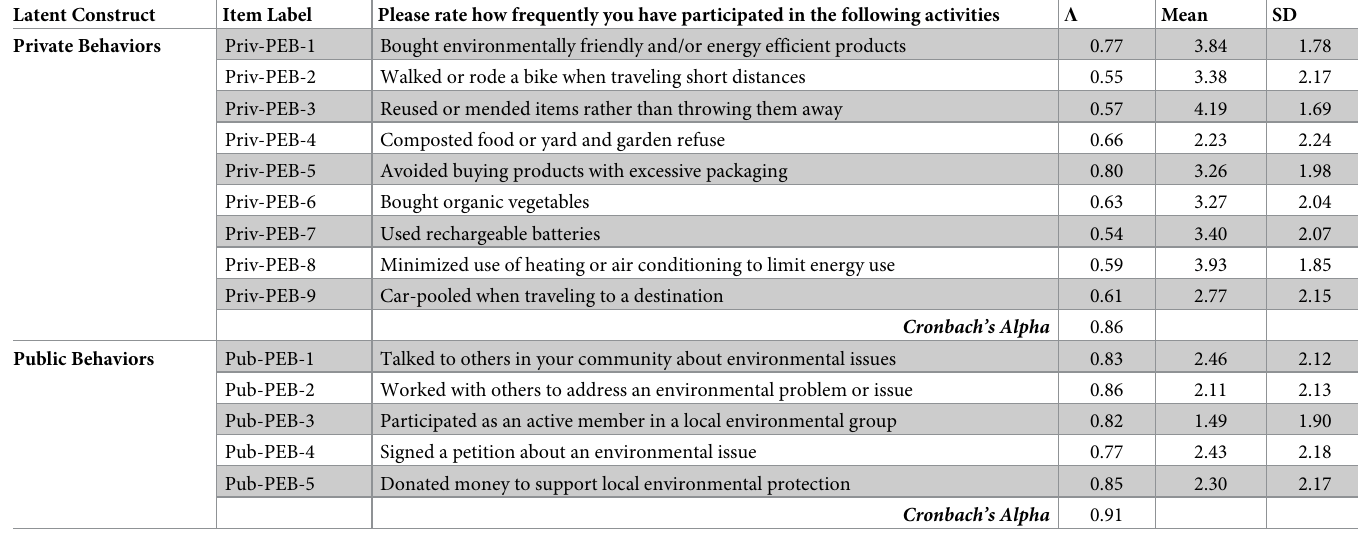
Table 1. Preliminary PEB items retained following the pilot study, including results from reliability analyses and confirmatory factor analyses. Latent